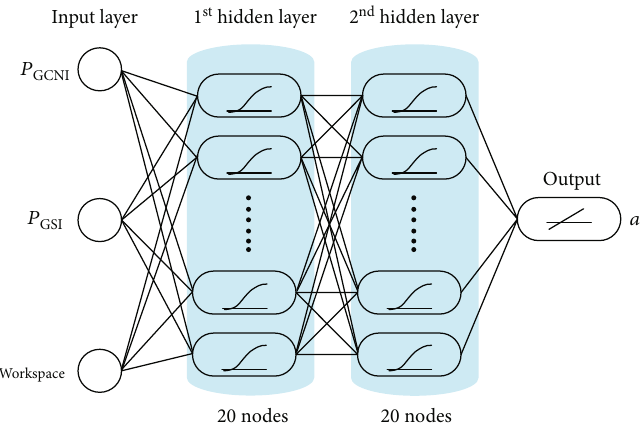
Figure 8: The topology of the BP neural network.